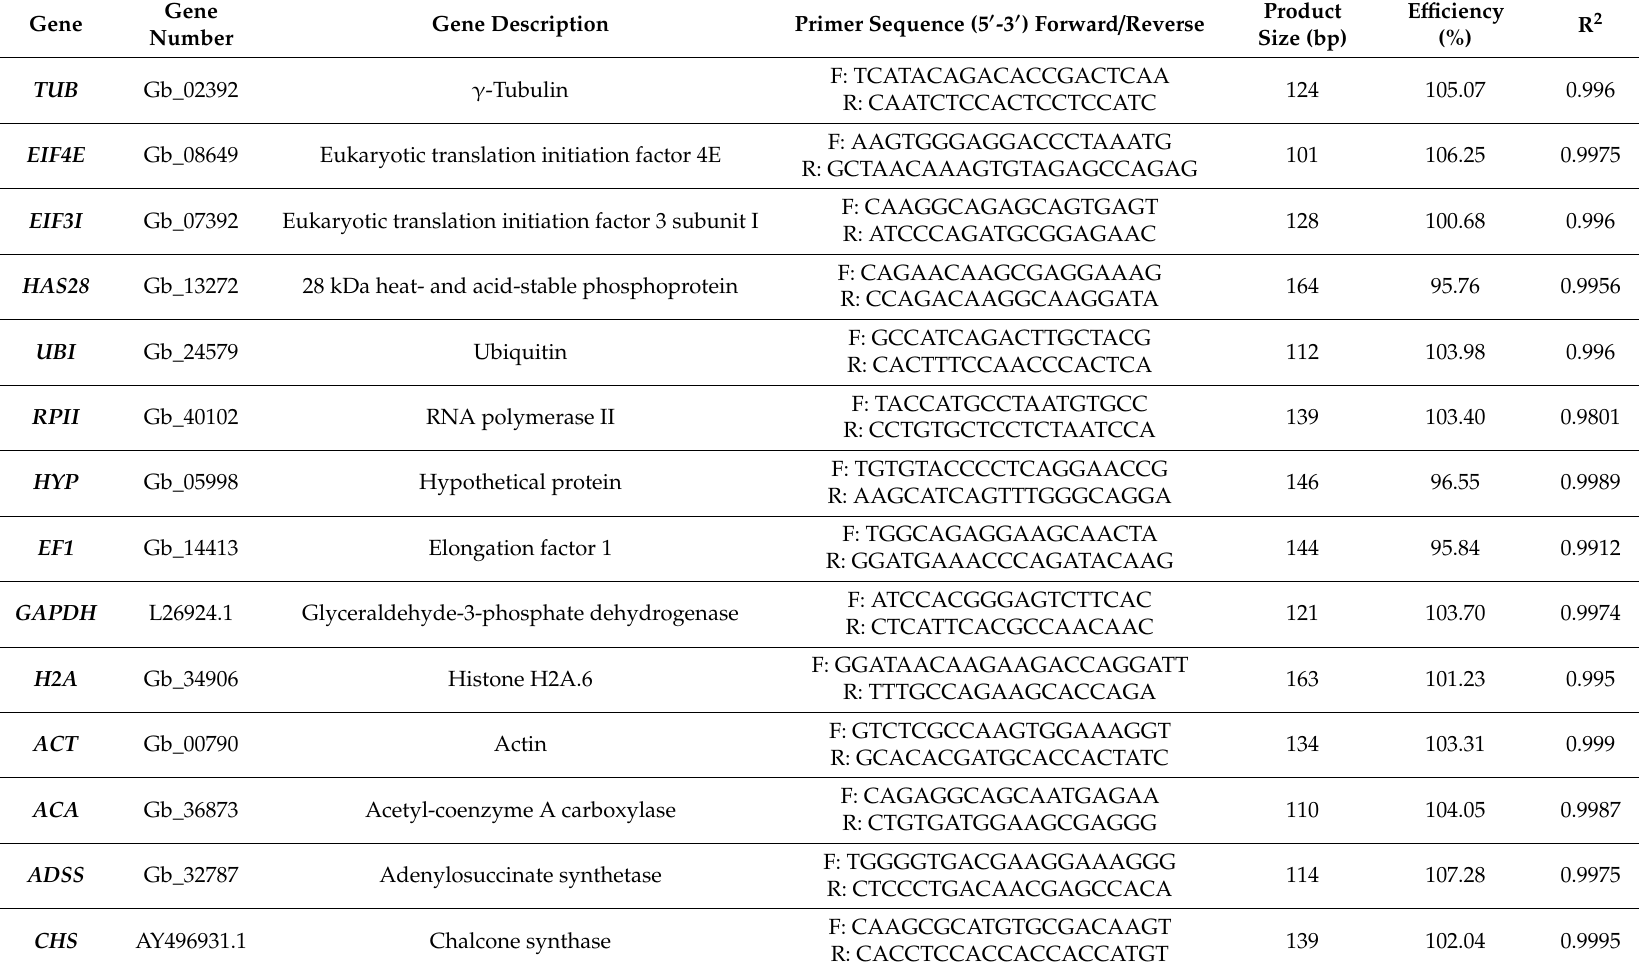
Table 1. Description of reference genes and associated primers used for the quantitative real-time polymerase chain reaction (qRT-PCR) study.